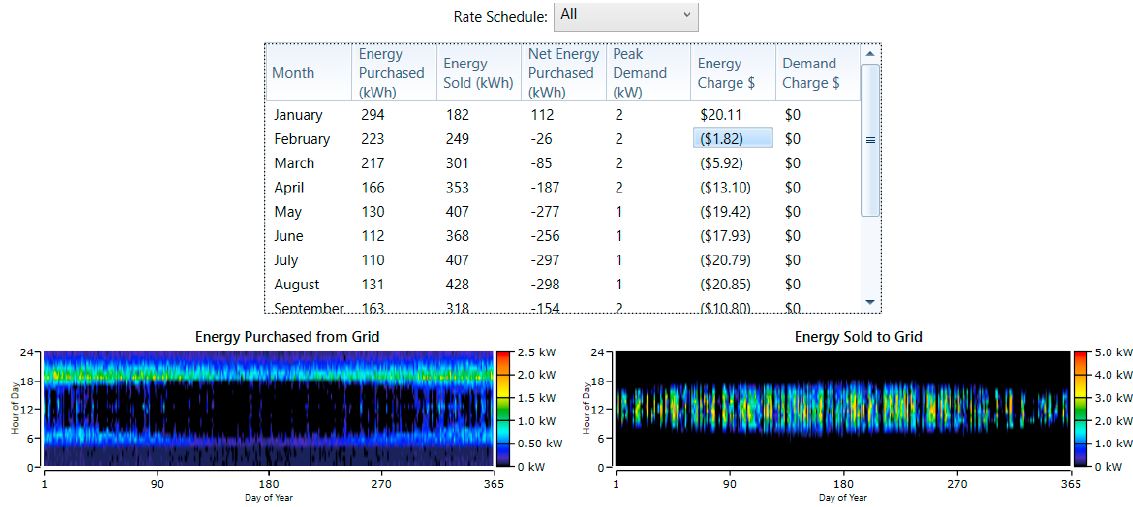
Figure 21. Simulations of produced and purchased energy and the table shows the price characteristics by months.